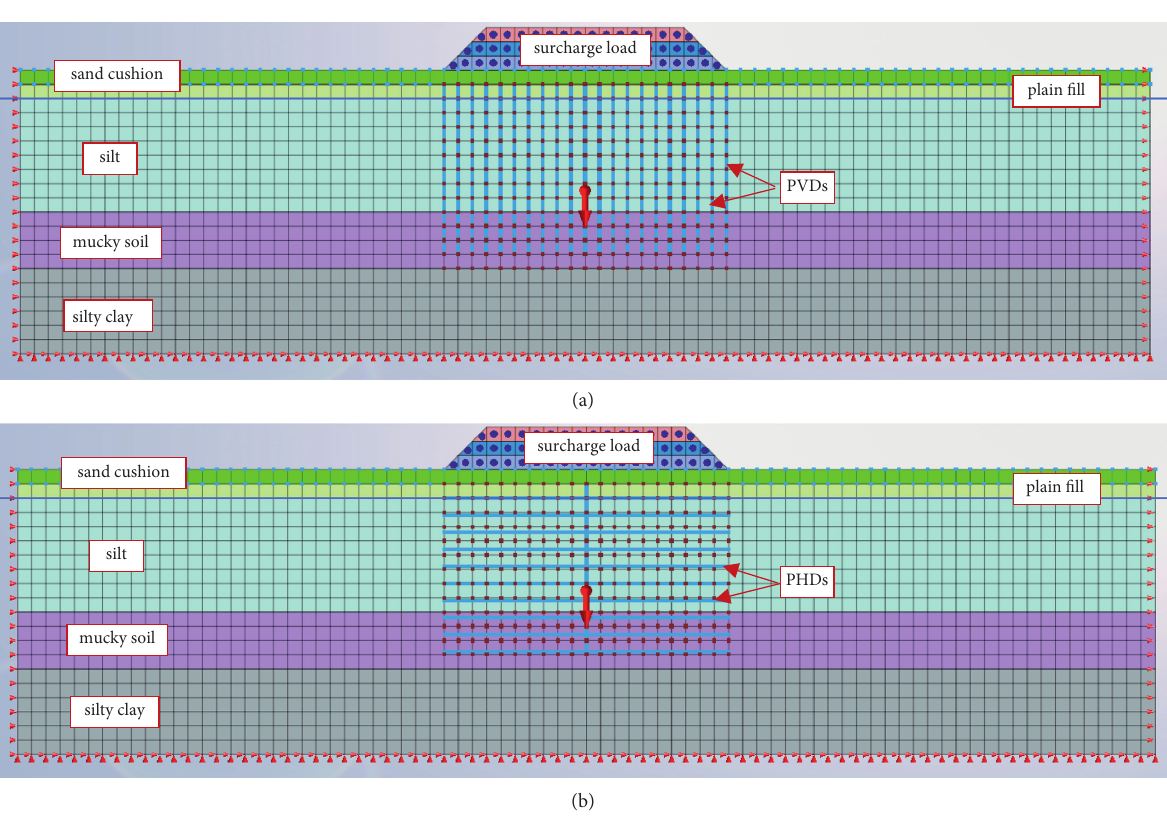
Figure 2: Finite element model of vacuum combined surcharge preloading: (a) PVDs and (b)